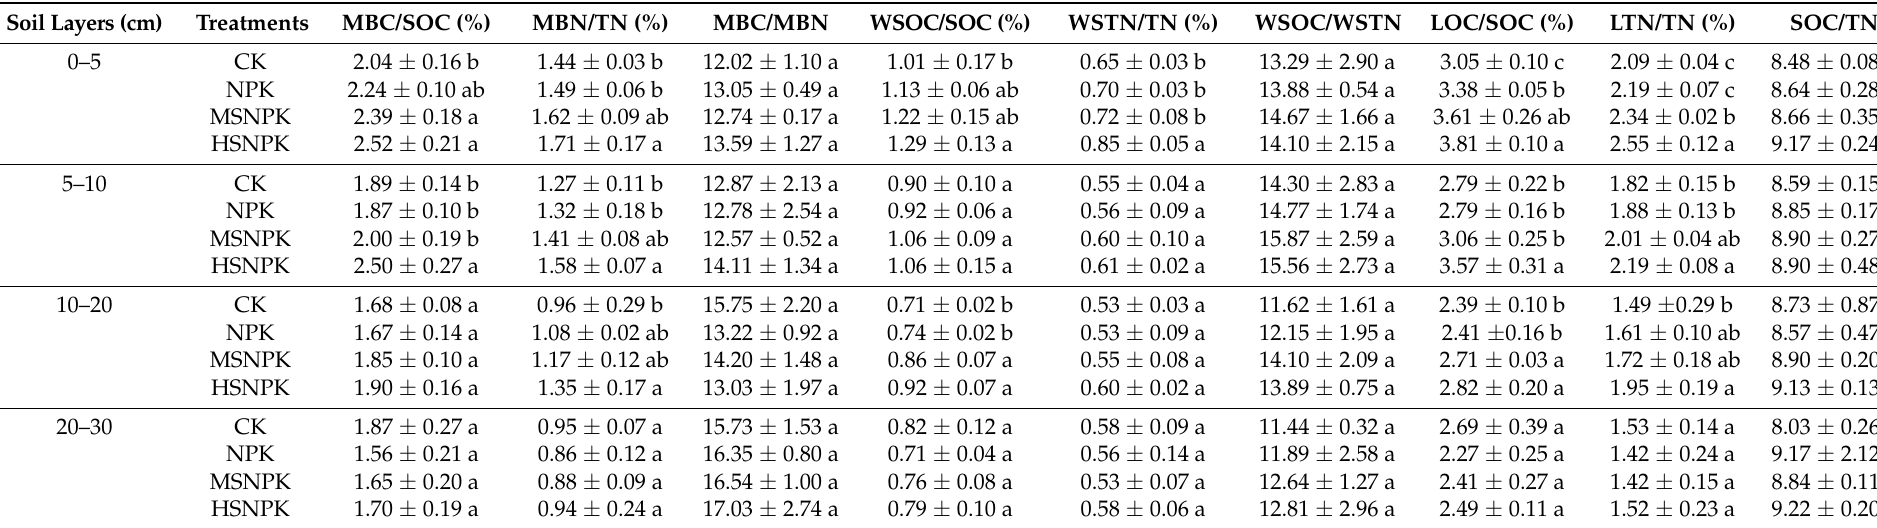
Table 2. Relevant C/N ratios among different treatments at different soil